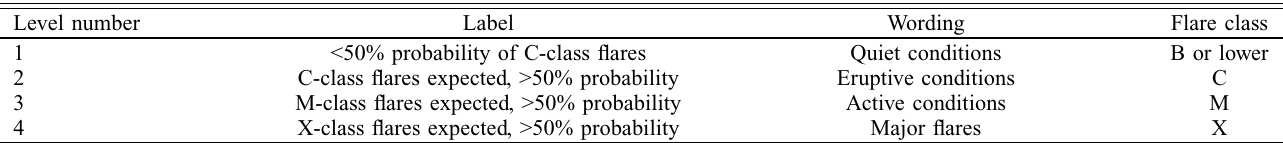
Table 1. Levels of flare activity used in forecasting. The label and the wording occur in the daily bulletin. The flare class is the level defined to compare the forecasts to